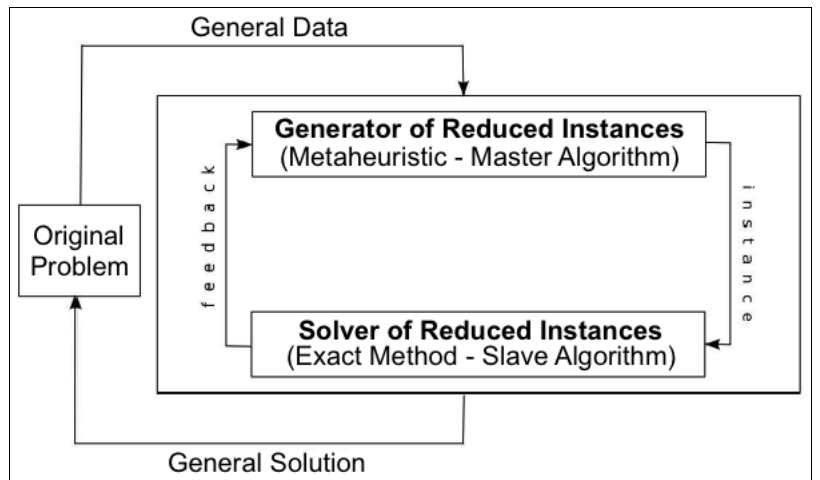
Figure 1. Generate-and-solve